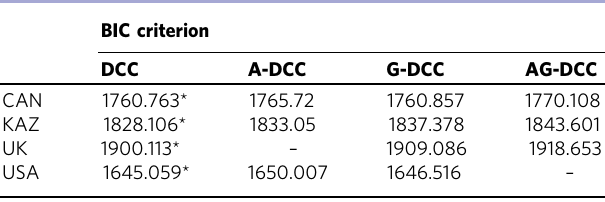
Table 7 The model selection of four speci fi cations for DCC